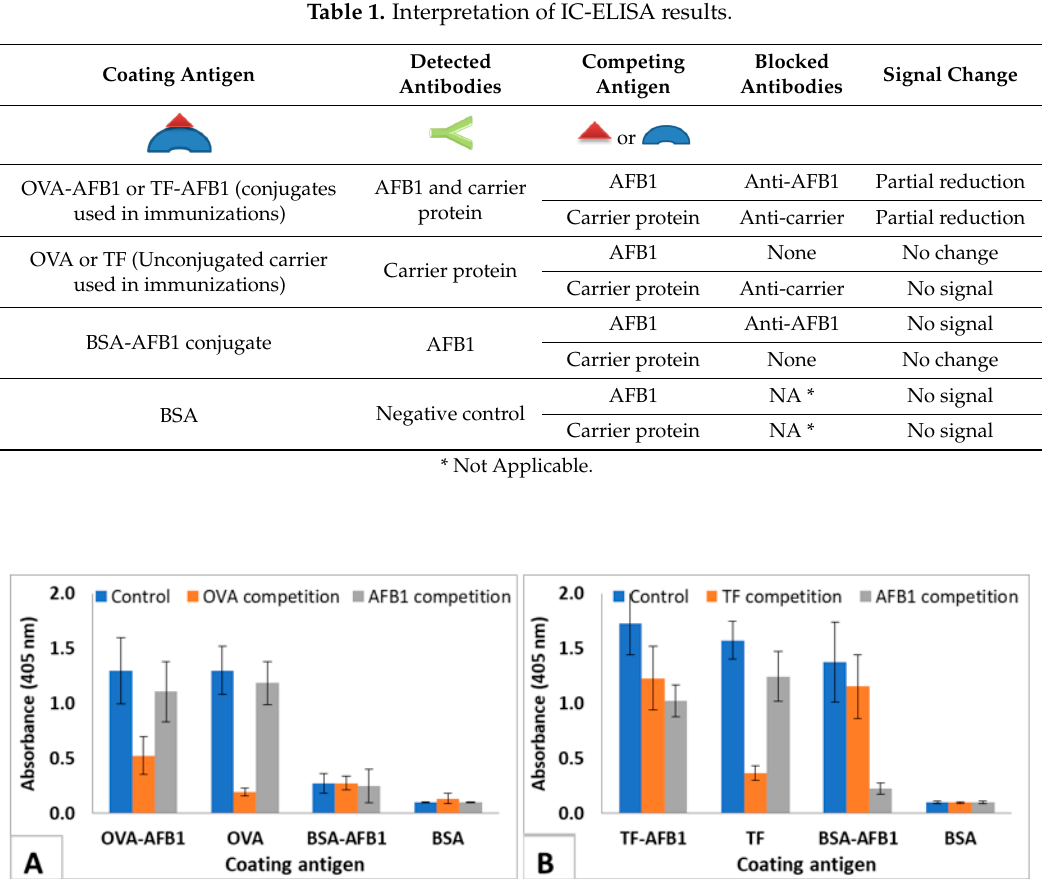
Table 2. Hybridoma fusion conditions and results.